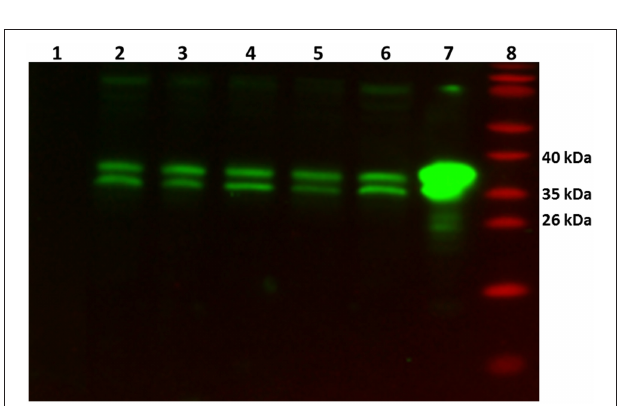
FIGURE 2 | Detection of the native GlnR protein in the cell lysate from S. coelicolor M145 cultivated under different defined nitrogen conditions. Western blot analysis of GlnR probed with anti-GlnR antibodies generated in rabbit (1:5000) and the secondary goat anti-rabbit antibodies conjugated with HRP (1:3000). Lane 1: cell lysate from glnR mutant grown in S-medium (200 µ g of total protein)—negative control, Lane 2–6: S. coelicolor M145 cell lysates (200 µ g of total protein, each). Cell lysates generated from cells grown in complex S-medium (Lane 2), in defined Evans medium with 5mM NH 4 Cl (Lane 3), 100mM NH 4 Cl (Lane 4), 5mM NaNO 3 (Lane 5), and 100mM NaNO 3 (Lane 6). Lane 7: cell lysate from the Strep-GlnR overexpression strain grown in S-medium—positive control. Lane 8: PageRuler Prestained Protein Ladder (Fermentas). Location of the GlnR with the estimated molecular masses of ∼ 35 and 38 kDa.